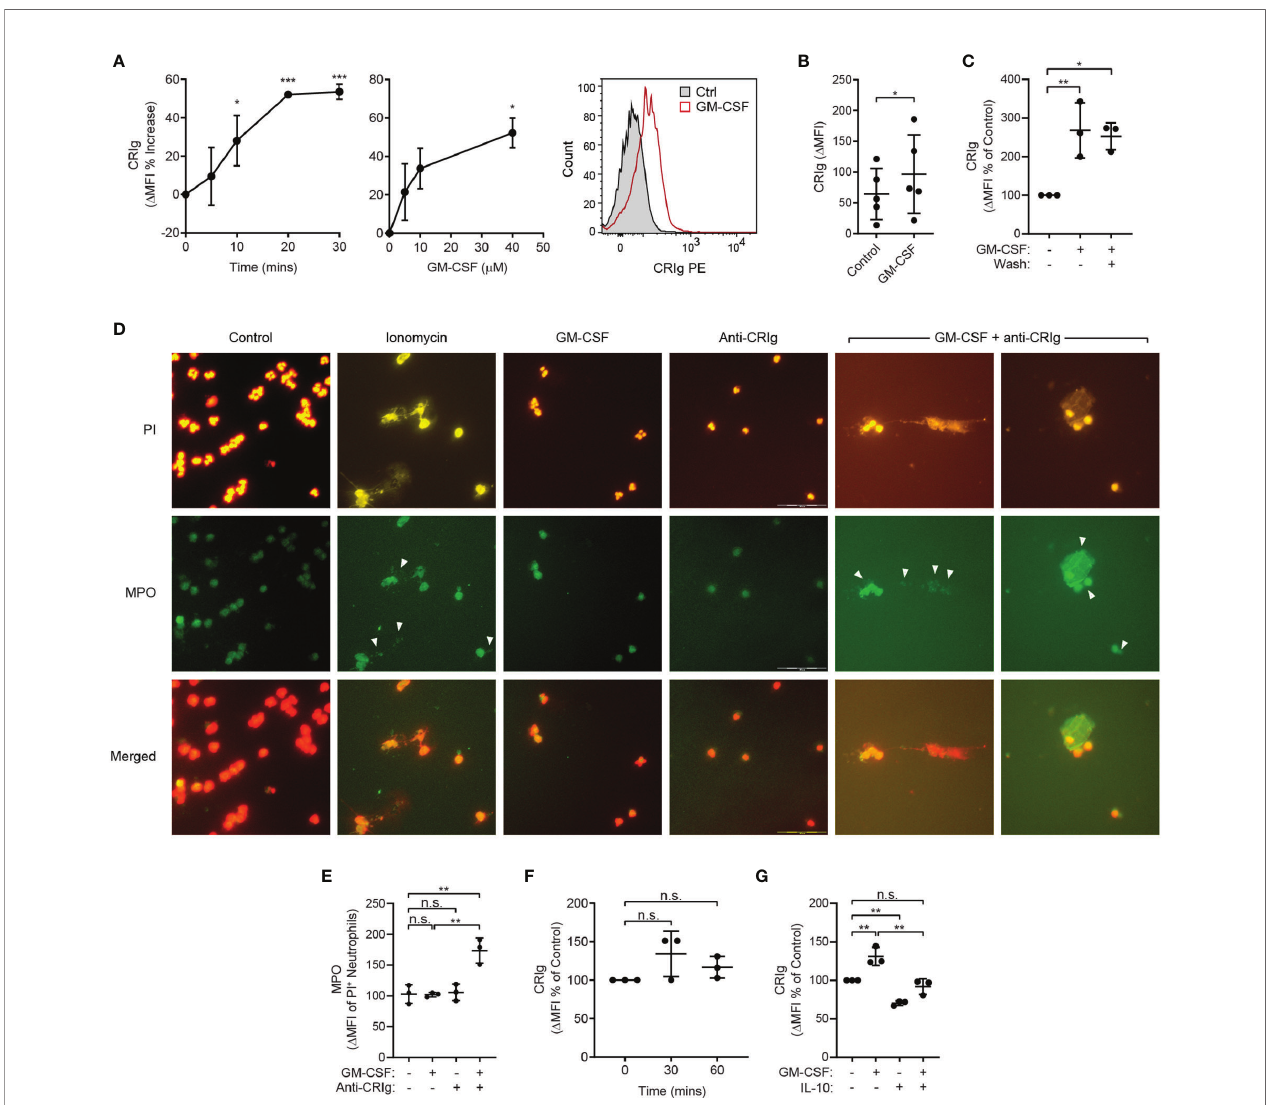
FIGURE 3 | Effect of GM-CSF on CRIg expression and CRIg-induced release of NETs and regulation by IL-10. (A) CRIg expression on activated neutrophils. Data show changes in CRIg expression by fl ow cytometry on the surface of neutrophils over time in response to GM-CSF (40 ng/mL) and the cytokine concentration related effect at 30 min. Expression was calculated as D MFI and then these were expressed as a percentage increase over control treatment ( n = 3 experiments). (B) Summary of the stimulation of neutrophil CRIg expression by GM-CSF for 30 min incubation and a concentration 40 ng/mL. Measurements were taken from distinct specimens and graphs show mean ± SD of these experiments. (C) Shows the effect of washing (Wash) the cells after priming with GM-CSF. Neutrophils were treated for 10 min with 40 ng/mL GM-CSF and then either washed or left intact. After a further 10 min incubation the level of surface CRIg was assessed by fl ow cytometry. (D) examination of CRIg induced NET release. Photomicrographs show the release of NETs caused by anti-CRIg antibody only after priming with GM-CSF, with no effect seen by treating neutrophils with GM-CSF or anti-CRIg antibody alone. Shown is the PI staining, MPO staining using indirect immuno fl uorescence and the combination of staining for DNA and MPO. In these investigations the neutrophils were treated with 25 ng/mL of GM-CSF for 20 min and then with anti-CRIg antibody. The cells were examined after a further 18 h incubation. Scale is represented by lines in the photo. (E) the NETs were semi-quantitated by fl ow cytometry. Data shows the MPO expression on PI labelled cells. (F) Shows the effects of neutrophil priming by plasma coated surfaces on CRIg expression over 60 min incubation. Data are presented as individual values and as mean ± SD of these values/experiments. (G) Shows the effects of IL-10 (100 ng/mL) on basal and GM-CSF (40 ng/mL) on CRIg expression in neutrophils. One-way ANOVA with Dunnett ’ s (A, C, G) or Sidak ’ s (E, F) post-test compared between all treatments and (B) Two-tailed, unpaired t-test compared with control expression. Signi fi cance levels are indicated by asterisks: * P < 0.05, ** P < 0.01, *** P < 0.001, n.s., not signi fi